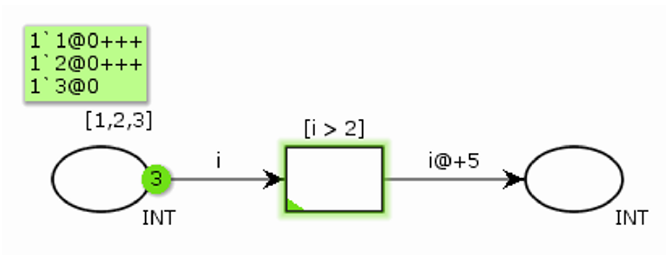
Figure 2. Example of Colored Petri Nets